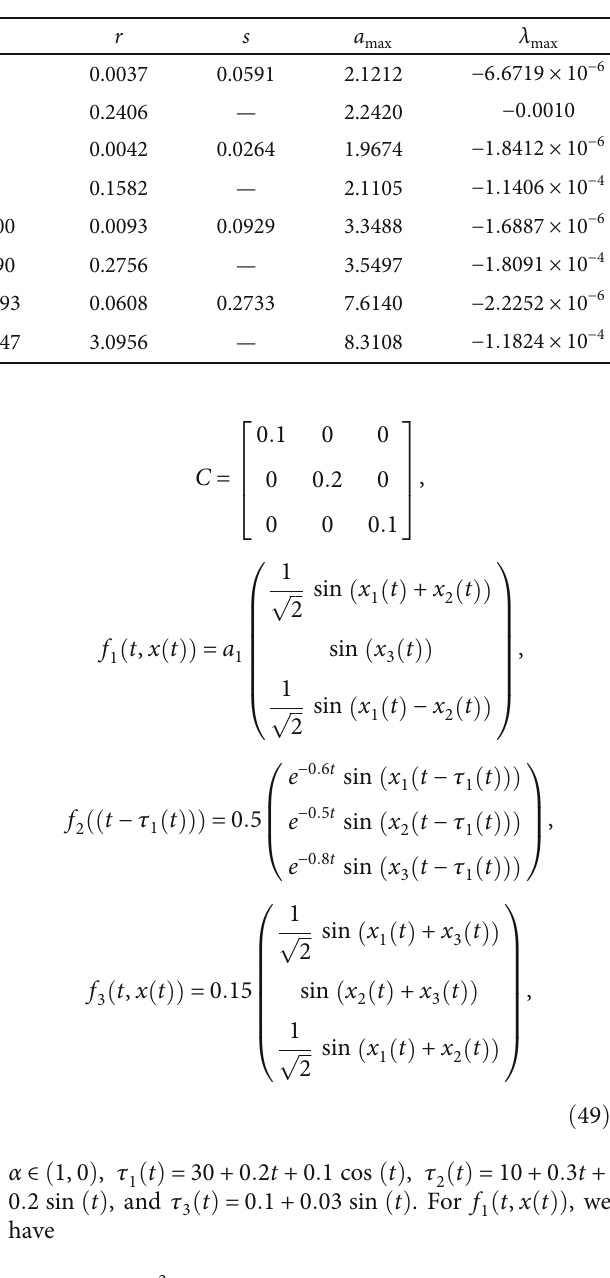
Table 2: Numerical solutions for Example